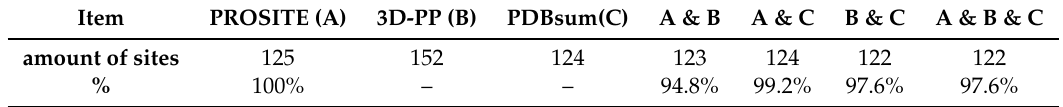
Table 1. Number of sites containing the Zinc finger C3H1-type motif at the sequence (PROSITE) and structural (3D-PP and PDBsum) levels. The last column (A & B & C) shows those sites that satisfy